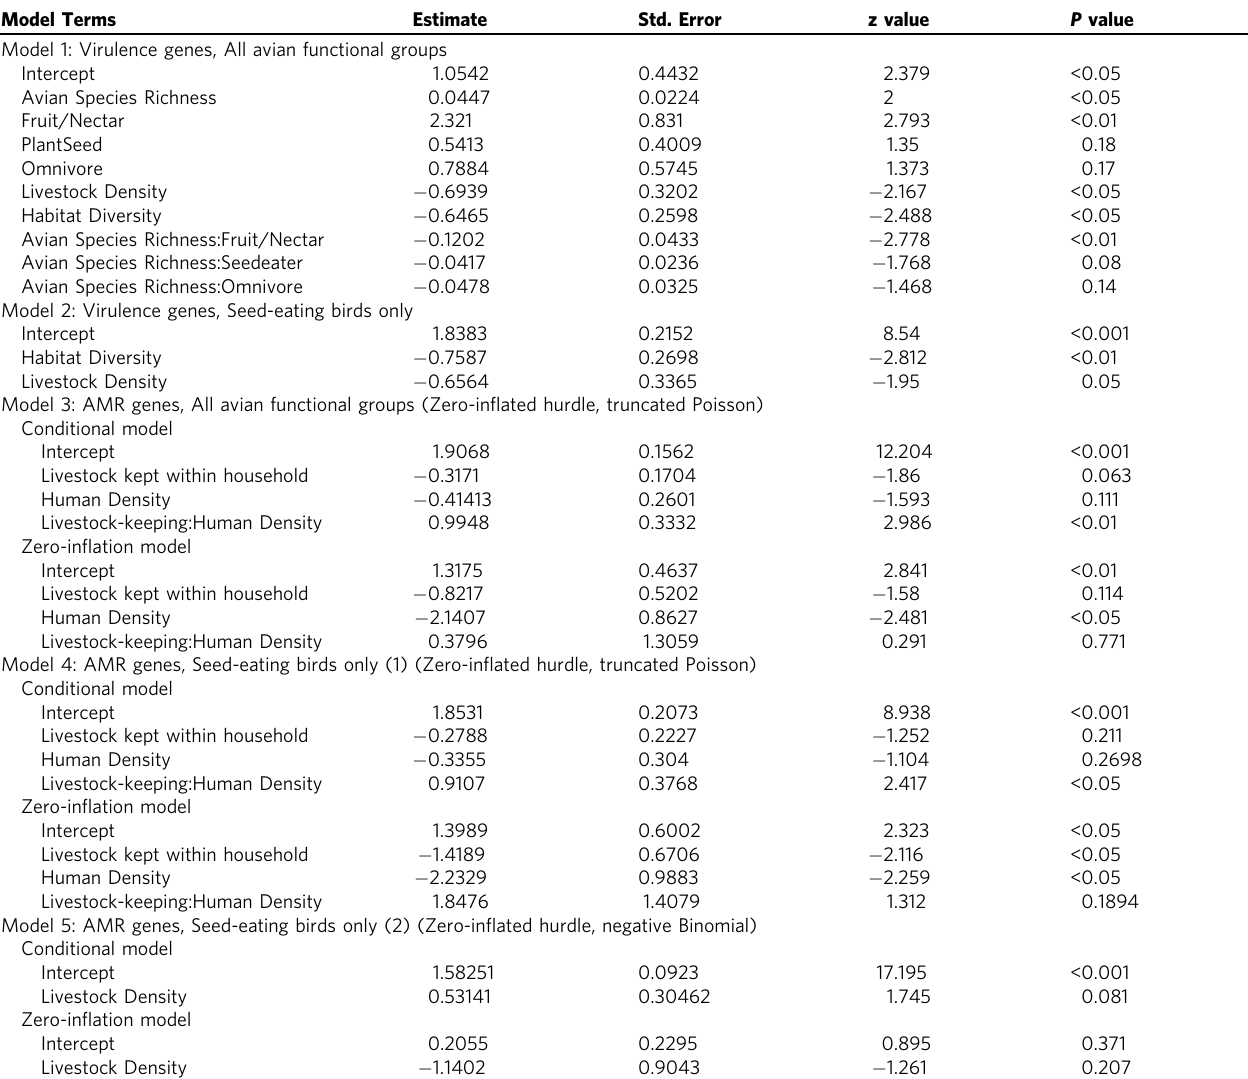
Table 1 Estimated regression parameters, standard errors, z-values and P values for optimal generalised linear models used in this study, modelling the diversity of avian-borne E. coli virulence and antimicrobial resistance (AMR) genes against household environmental